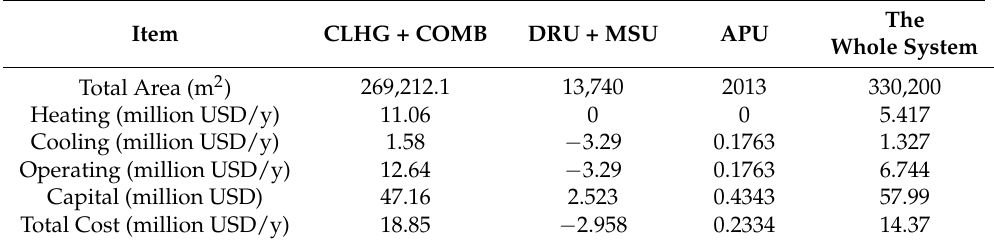
Table 3. Cost of